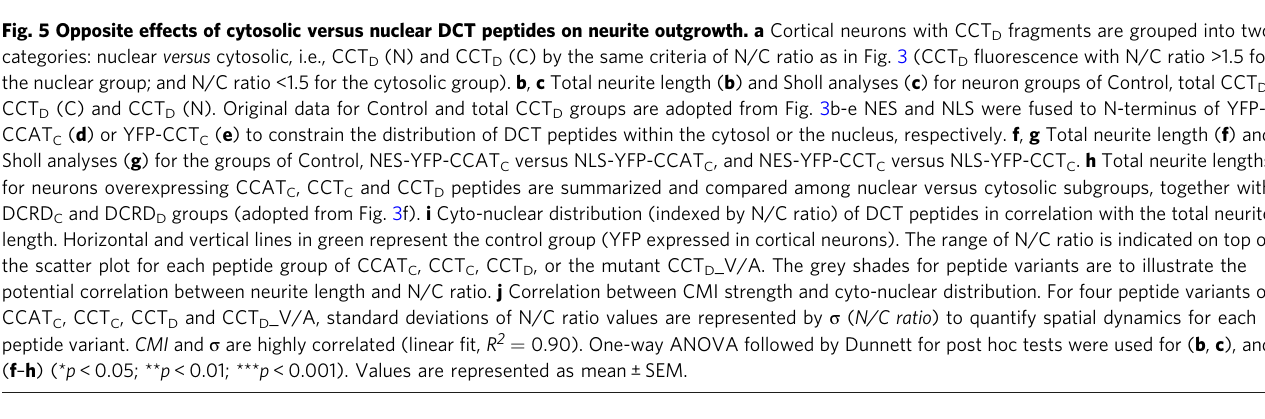
Fig. 5 Opposite effects of cytosolic versus nuclear DCT peptides on neurite outgrowth. a Cortical neurons with CCT D fragments are grouped into two categories: nuclear versus cytosolic, i.e., CCT D (N) and CCT D (C) by the same criteria of N/C ratio as in Fig. 3 (CCT D fl uorescence with N/C ratio >1.5 for the nuclear group; and N/C ratio <1.5 for the cytosolic group). b , c Total neurite length ( b ) and Sholl analyses ( c ) for neuron groups of Control, total CCT D , CCT D (C) and CCT D (N). Original data for Control and total CCT D groups are adopted from Fig. 3b-e NES and NLS were fused to N-terminus of YFP- CCAT C ( d ) or YFP-CCT C ( e ) to constrain the distribution of DCT peptides within the cytosol or the nucleus, respectively. f , g Total neurite length ( f ) and Sholl analyses ( g ) for the groups of Control, NES-YFP-CCAT C versus NLS-YFP-CCAT C , and NES-YFP-CCT C versus NLS-YFP-CCT C . h Total neurite lengths for neurons overexpressing CCAT C , CCT C and CCT D peptides are summarized and compared among nuclear versus cytosolic subgroups, together with DCRD C and DCRD D groups (adopted from Fig. 3f). i Cyto-nuclear distribution (indexed by N/C ratio) of DCT peptides in correlation with the total neurite length. Horizontal and vertical lines in green represent the control group (YFP expressed in cortical neurons). The range of N/C ratio is indicated on top of the scatter plot for each peptide group of CCAT C , CCT C , CCT D , or the mutant CCT D _V/A. The grey shades for peptide variants are to illustrate the potential correlation between neurite length and N/C ratio. j Correlation between CMI strength and cyto-nuclear distribution. For four peptide variants of CCAT C , CCT C , CCT D and CCT D _V/A, standard deviations of N/C ratio values are represented by σ ( N/C ratio ) to quantify spatial dynamics for each peptide variant. CMI and σ are highly correlated (linear fi t, R 2 = 0.90). One-way ANOVA followed by Dunnett for post hoc tests were used for ( b , c ), and